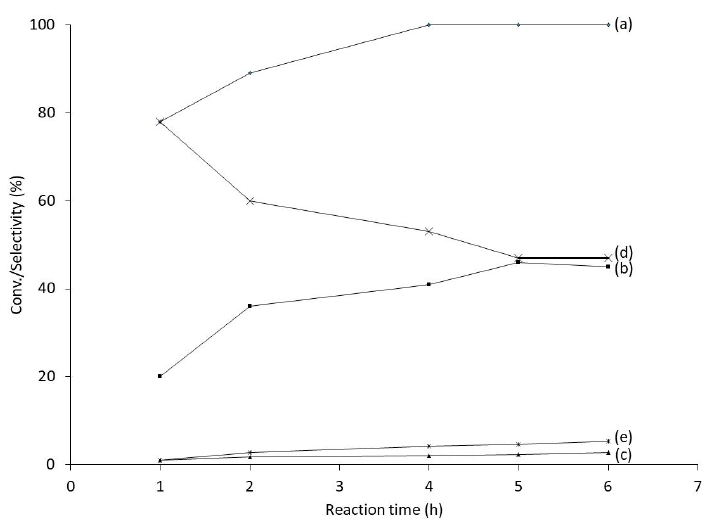
Figure 1. Reaction kinetic curves of liquid-phase dehydration of glycerol over ZSM-5_280 at 280 °C and a catalyst/sulfolane/glycerol mass ratio of 0.05/3/1: (a) conversion, (b) selectivity to acrolein,